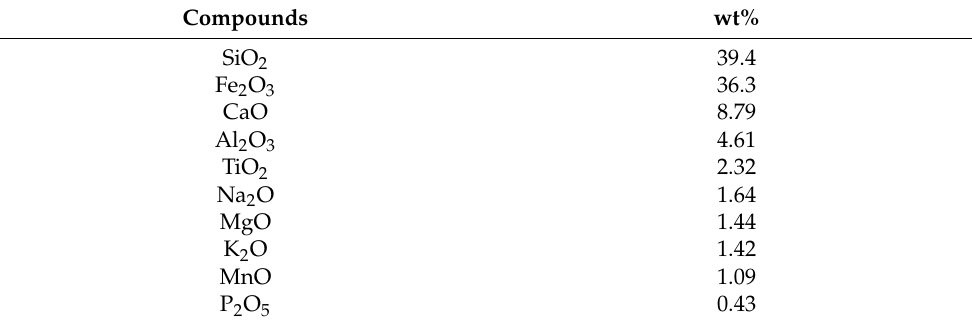
Table 2. Major chemical components in the